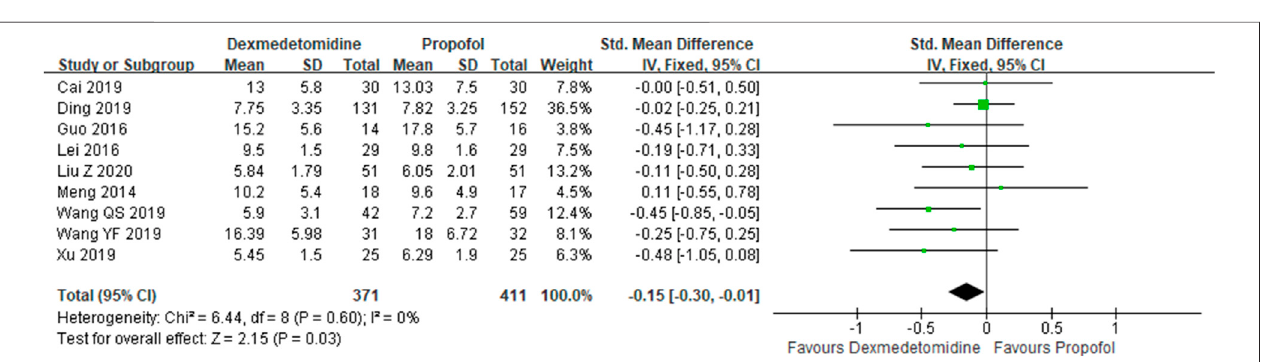
FIGURE 5 | Forest plot of Incidence of adverse